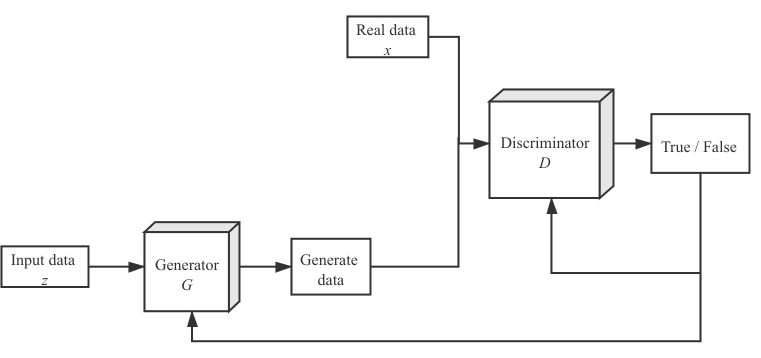
Figure 6. Flow chart of generative adversarial networks.